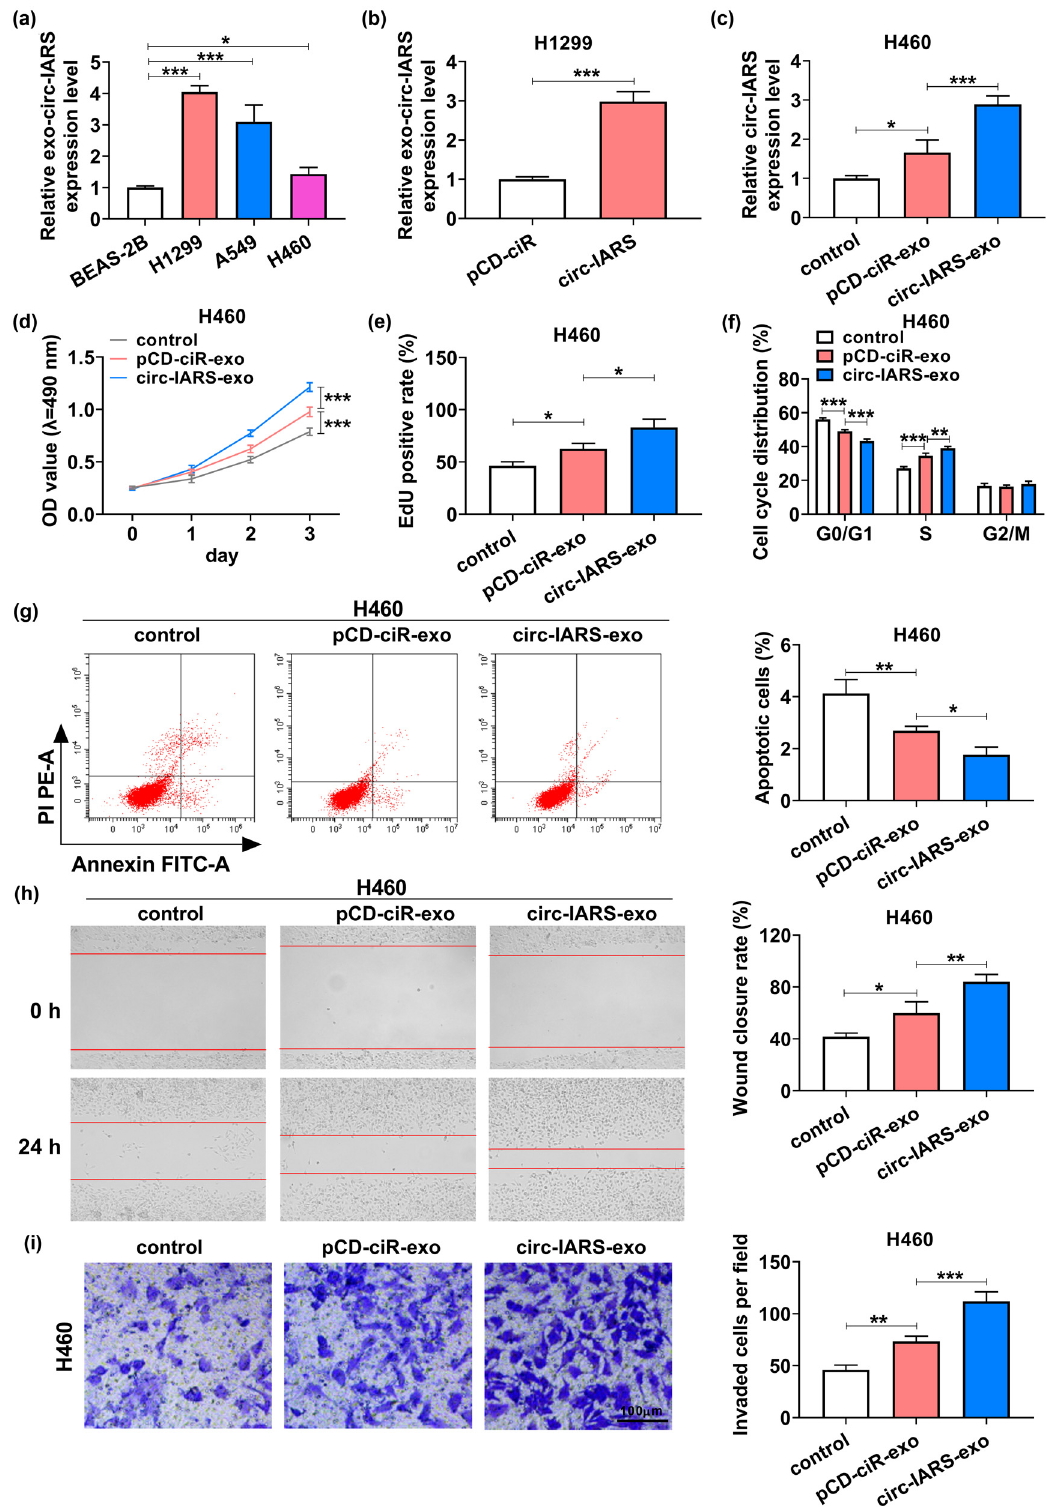
Figure 8: Ex - circ - IARS contributed to the growth, migration, and invasion of NSCLC cells in vitro . ( a and b ) RT - qPCR detected the relative exo - circ - IARS expression level in ( a ) BEAS - 2B, H1299, A549, and H460 cells, and ( b ) H1299 cells transfected with circ - IARS or pCD - ciR vector. ( c – i ) H460 cells were co - cultured with H1299 cells - based exosomes after circ - IARS or pCD - ciR vector transfection ( pCD - ciR - exo or circ - IARS - exo ) , normalized to control cells ( without exosome treatment ) . ( c ) RT - qPCR detected the relative circ - IARS expression level. ( d ) MTT assay monitored the OD value at 490 nm. ( e ) EdU assay determined the EdU - positive rate. ( f and g ) FCM method analyzed the cell cycle distribution ( % ) and apoptotic cells ( % ) . ( h ) Scratch wound assay measured the wound closure rate. ( i ) Transwell assay examined the number of invaded cells per fi eld ( 100 ×) . * P < 0.05, ** P < 0.01, and *** P <